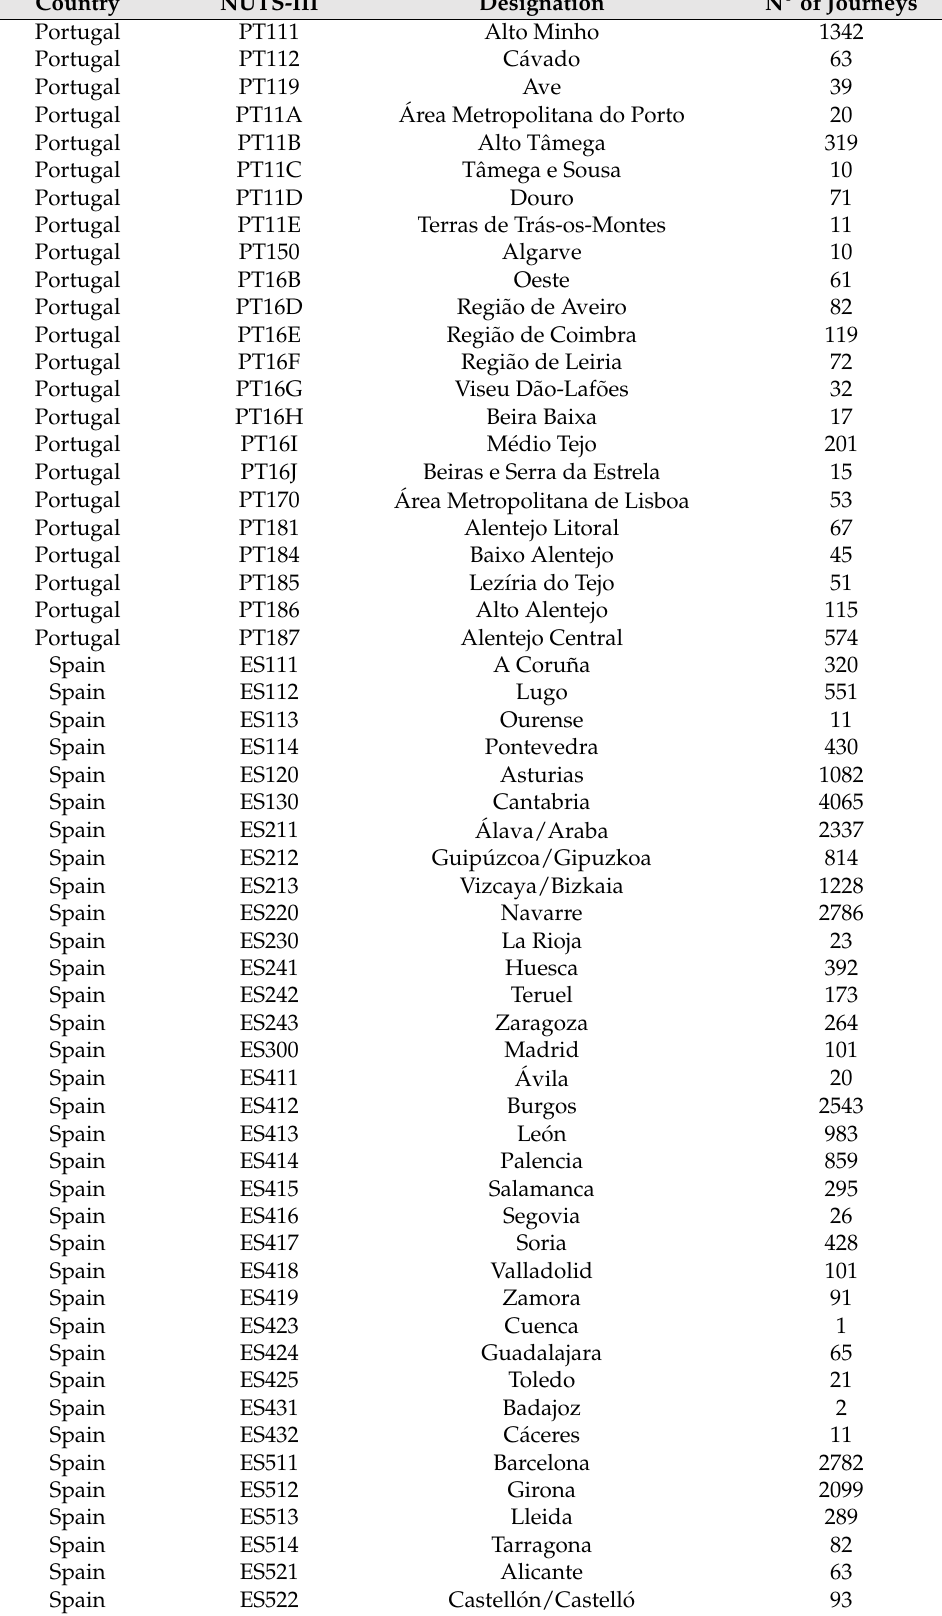
Table A2. List of NUTS-III and the respective number of journeys.